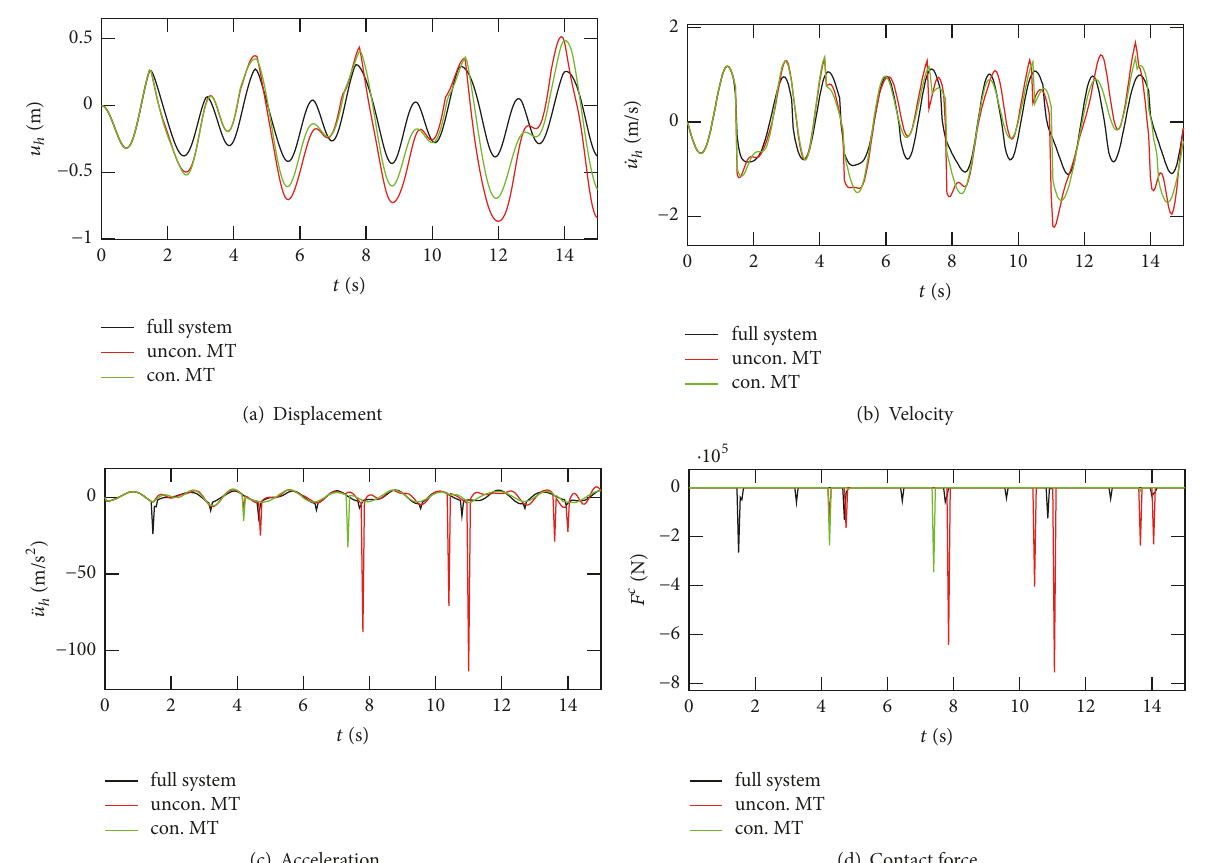
Figure 6: Results for the displacement, the velocity, and the acceleration as well as the contact force with 𝑚 = 6